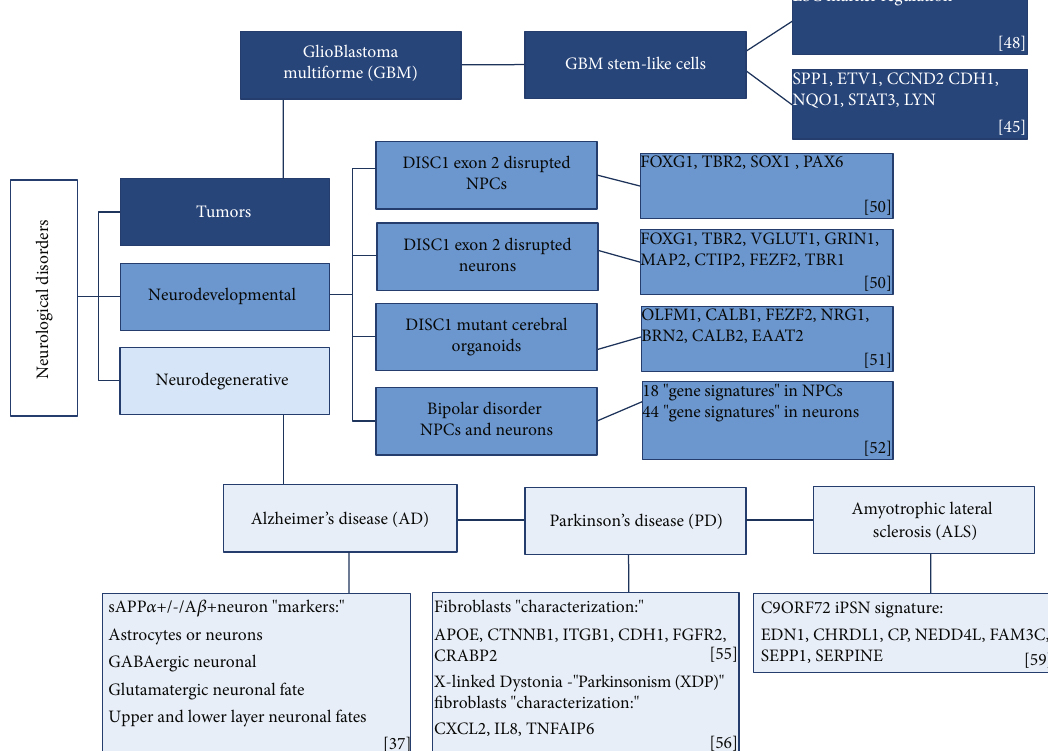
Figure 2: Molecular barcoding gene signatures in diseases of the nervous system. The fi gure shows gene expression signatures identi fi ed by molecular barcoding in several neurological diseases. References are